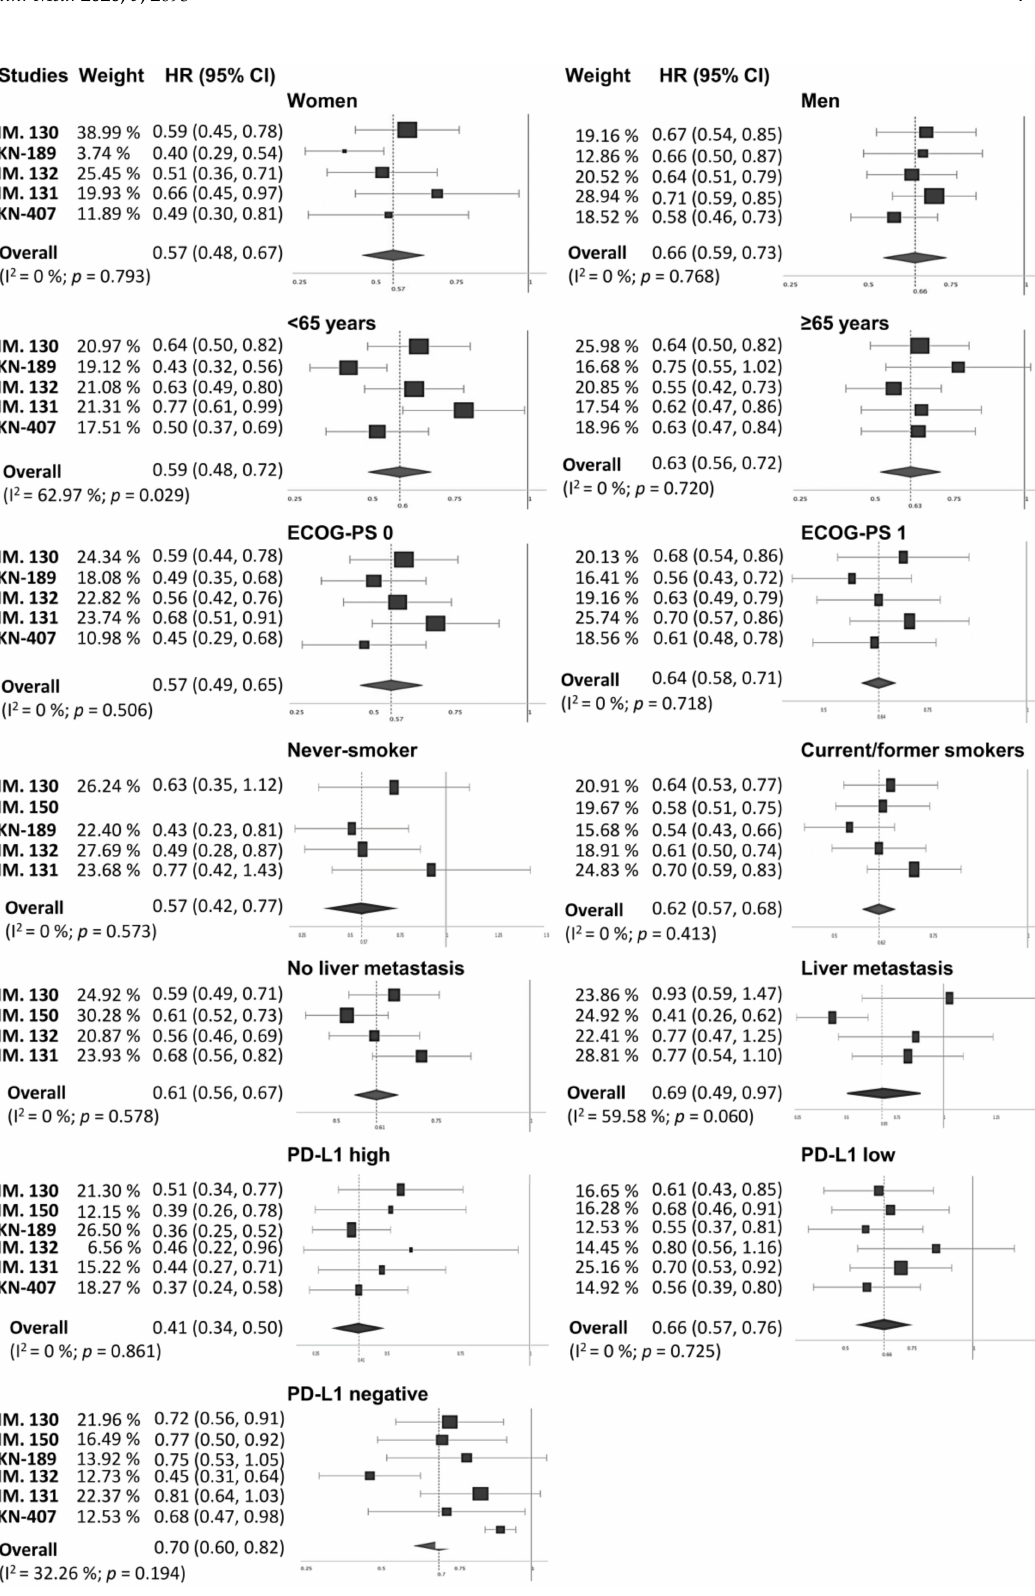
Figure 4. Forest plot of hazard ratios for progression-free survival (PFS) in the di ff erent patient subgroups. CI, confidence interval; ECOG-PS, Eastern Cooperative Oncology Group performance status; HR, hazard ratio; IM., IMpower; KN,